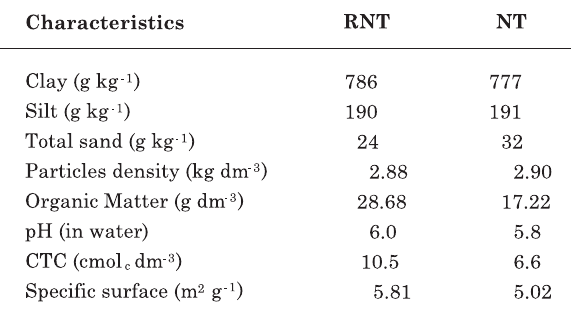
Table 1. Physical, chemical and mineralogical characteristics of soil samples collected under a no-till system with crop rotation (RNT) and without crop rotation (NT) between 0.0 and